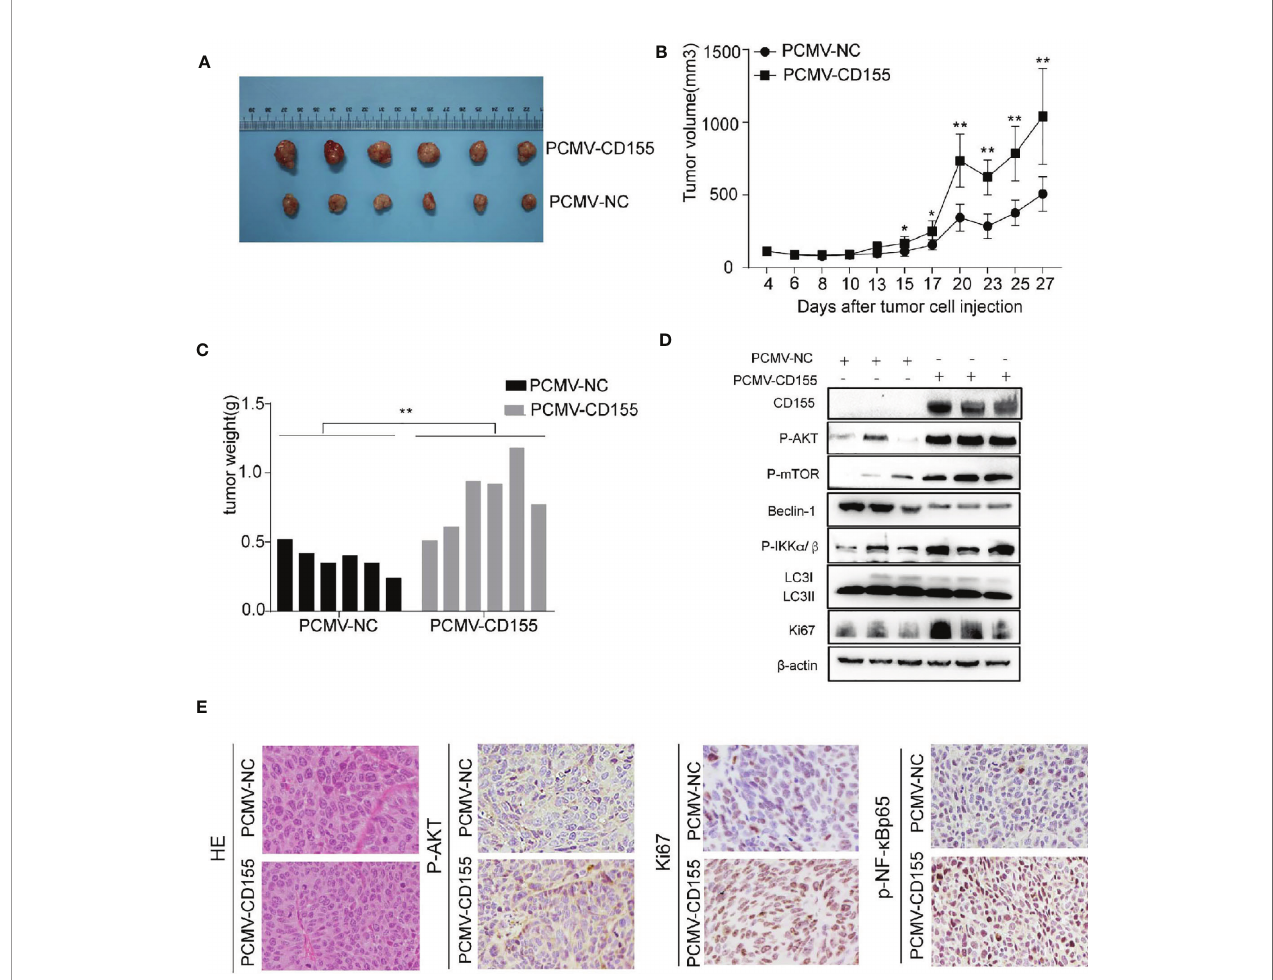
FIGURE 6 | CD155 overexpression promotes cervical cancer growth in vivo . (A) Images of xenograft tumors derived from cells transfected with PCMV-CD155 or PCMV-NC. (B) The volumes of xenograft tumors derived from cells transfected with PCMV-CD155 or PCMV-NC. (C) The weight of xenograft the formed tumors derived from cells transfected with PCMV-CD155 or PCMV-NC. (D) Western blotting was used to detect protein expression in tumor forming tissues in vivo . The LC3BII/LC3BI ratio and protein expression of Beclin-1 were signi fi cantly decreased in the PCMV-CD155 group, while the protein expression of p-AKT, p-mTOR, P- IKK a / b and Ki67 was signi fi cantly increased. All data represent three independent experiments. The data were the mean ± SEM of at least three independent experiments. (E) Images of HE staining of xenograft tumors (200x). The expression of p-AKT, Ki67, and p-NF- k Bp65 in xenograft tumors was detected by IHC (200x). *P < 0.05, **P <